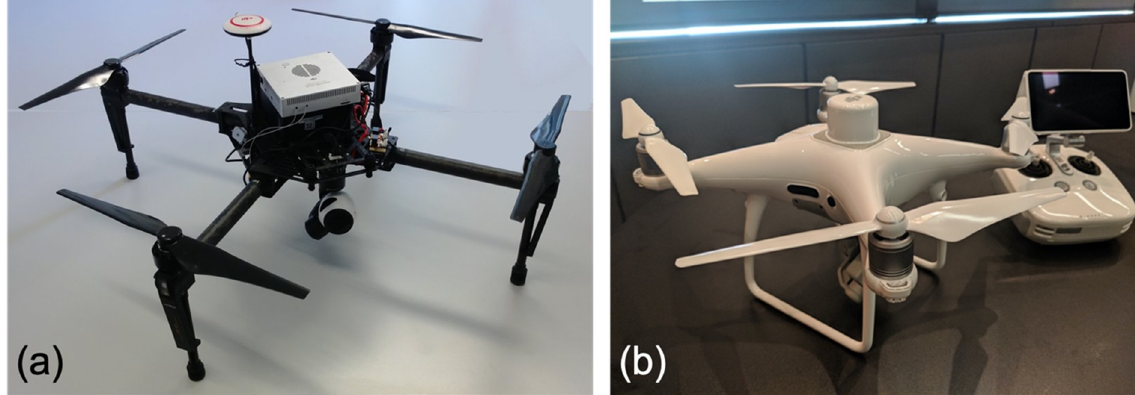
Figure 3. ( a ) DJI Matrice 100 UAV, with the Micasense and RGB Gimbal cameras attached. ( b ) DJI Phantom 4 RTK UAV. Table 1. Summary of Unmanned Aerial Vehicle (UAV) flight acquisitions with MicaSense RedEdge multispectral camera.